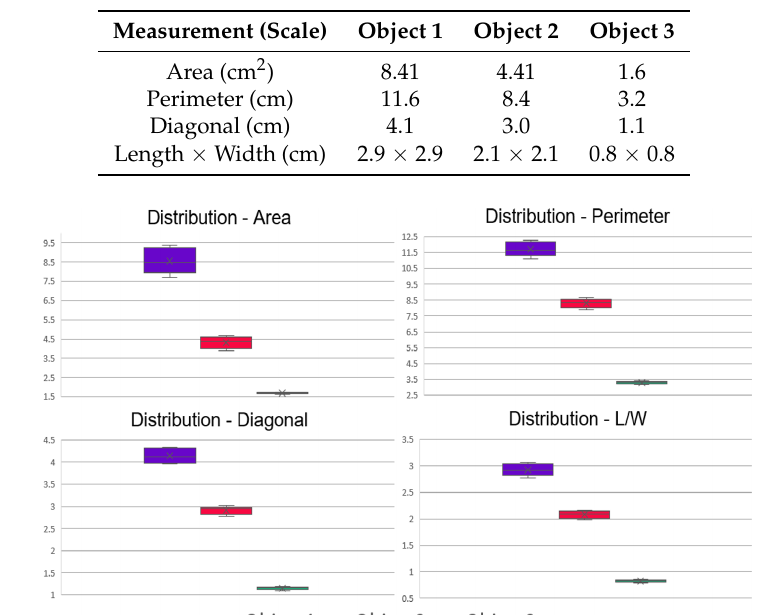
Figure 7. (Test Target) The printed target from the United States Air Force used for testing and measuring the heuristic calibration method. Table 1. The manual measurements of the printed target using a metric ruler. Object 1 is the largest object from Figure 7, Object 2 is the second largest object, and Object 3 is the smallest object.